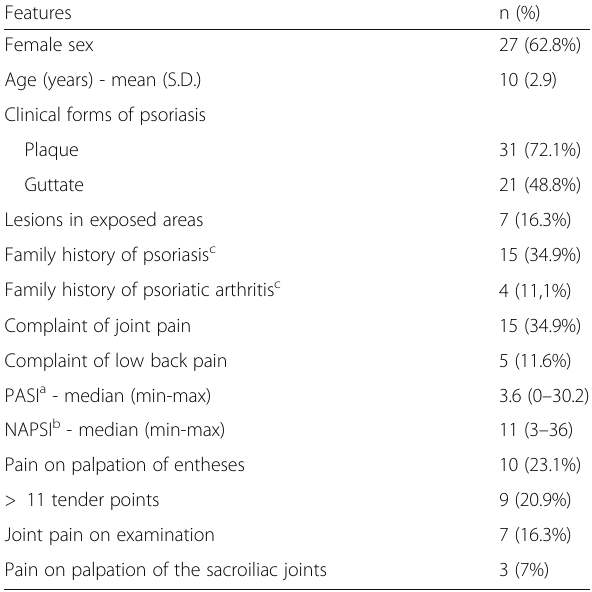
Table 1 General features of the 43 participants, psoriasis, and the findings of the rheumatologic examination Features